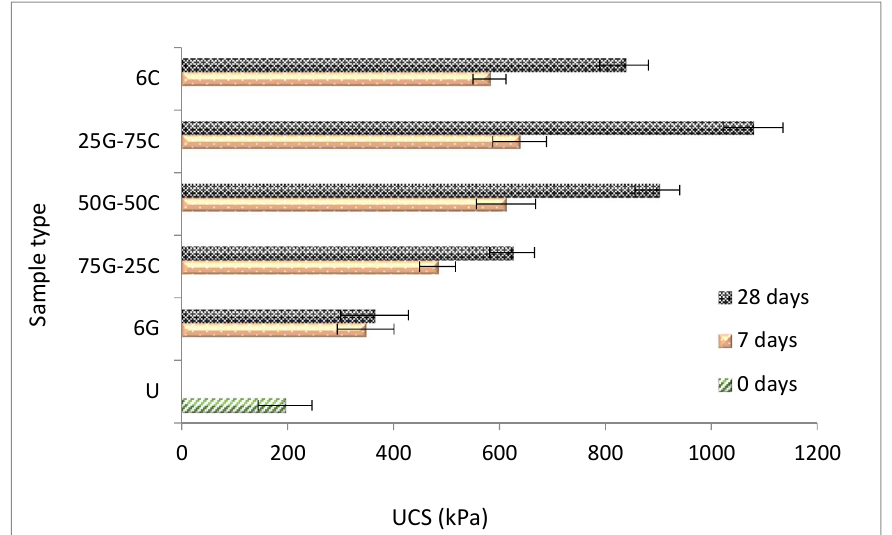
Figure 7. UCS of both treated and untreated soil samples at 7 and 28 days.